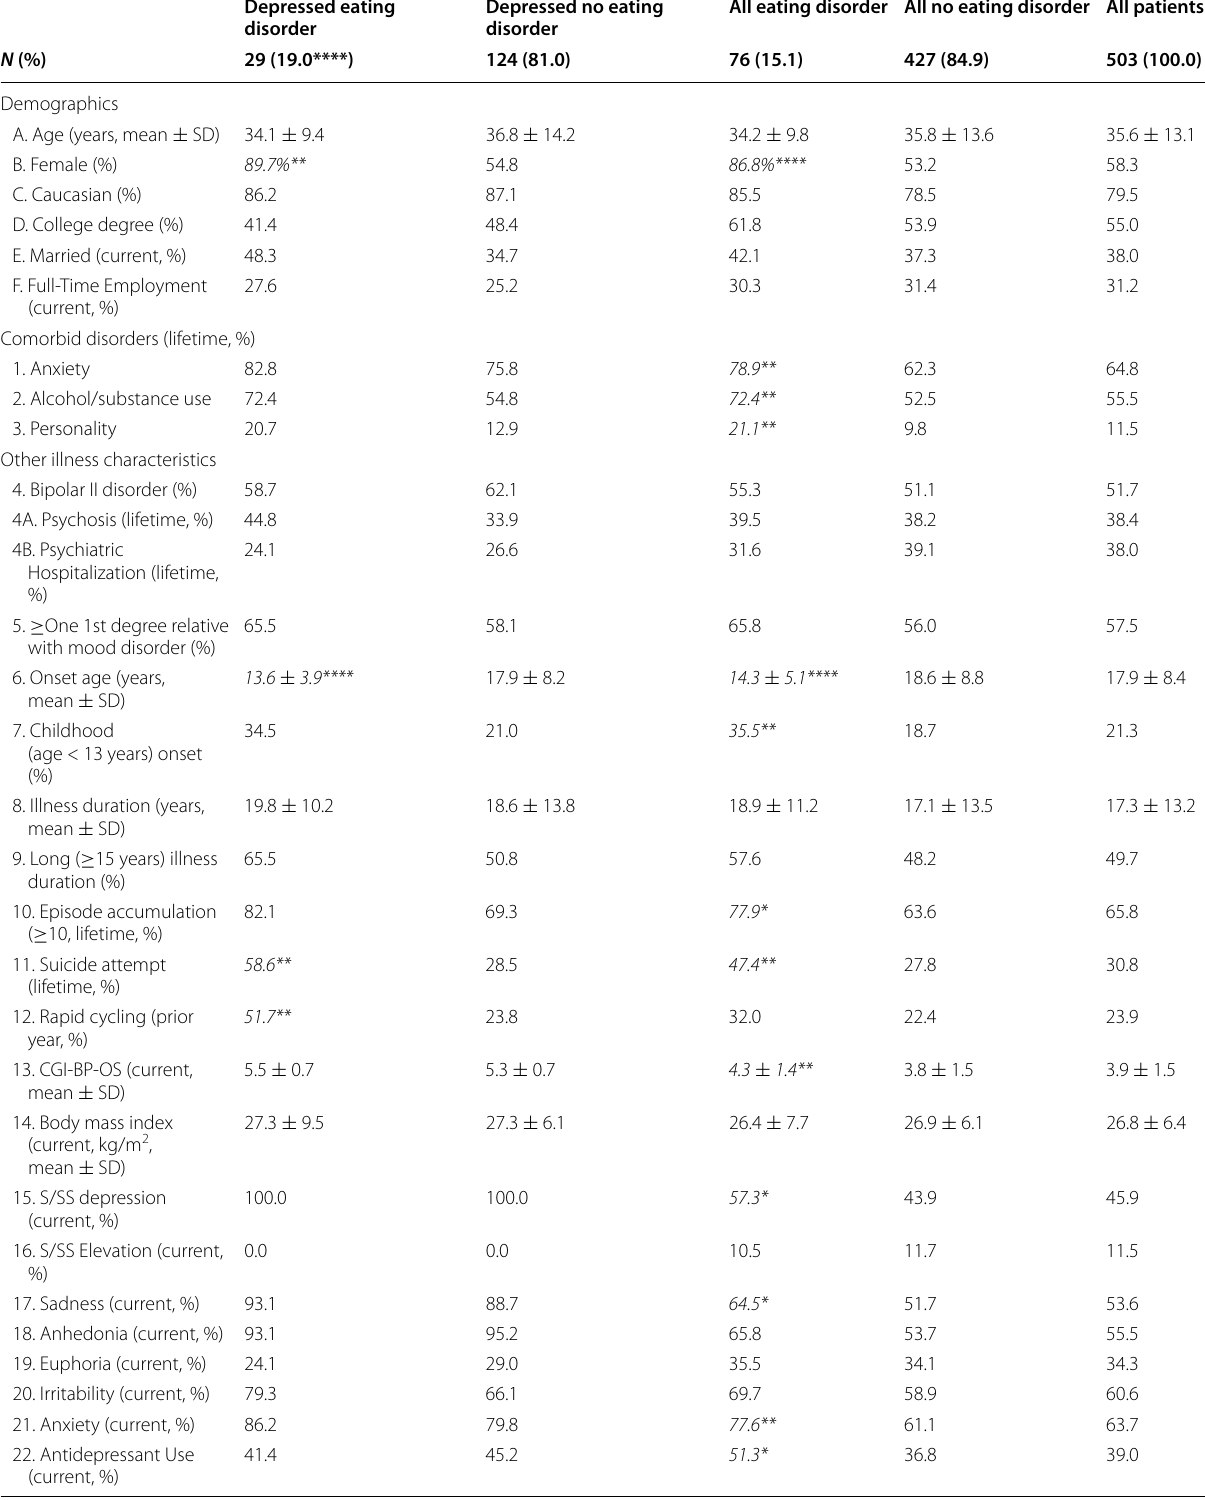
Table 1 Demographic and clinical correlates of eating disorder in bipolar disorder patients Depressed eating Depressed no eating All eating disorder All no eating disorder All disorder disorder